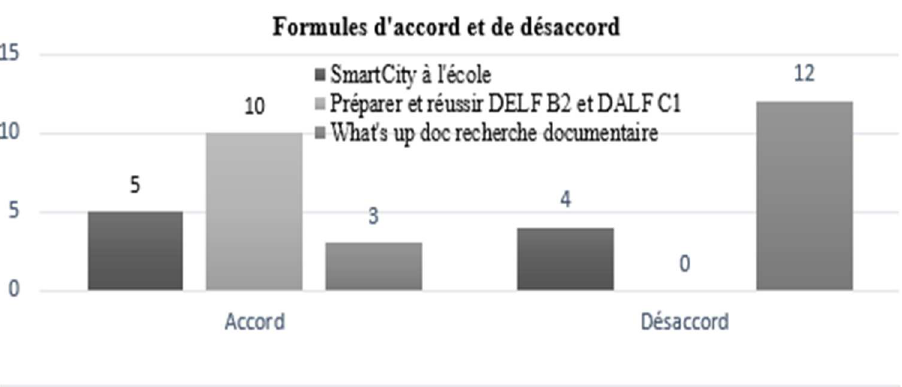
Fig. 1. Les formules d’ouverture de conversation sur les forums étudiés des trois MOOC.